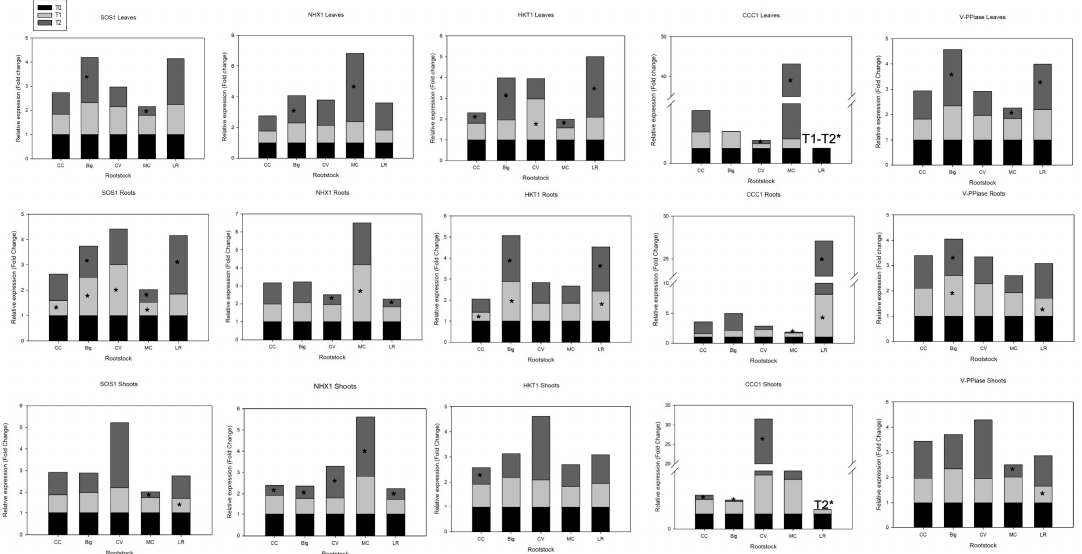
Figure 1. Expression profiles of SOS1, NHX1, HKT1, CCC1, and V-PPiase of ‘Hernandina’ clementine ( Citrus clementina hort. ex Tanaka) (willowleaf mandarin ( C. deliciosa ) × sweet orange ( C. sinensis (L.) Osbeck)) grafted on 5 citrus rootstocks in response to salt. Big: sour orange ( C. aurantium L.); CC: Carrizo citrange ( C. sinensis × Poncirus trifoliata (L.) Raf); CV: Volkamer lemon ( C. volkameriana V. Ten. & Pasq.); LR: Rangpur lime ( C. limonia Osbeck); and MC: Cleopatra mandarin ( Citrus reshni hort. ex Tanaka). For each combination (rootstock/‘Hernandina’), stacked panels showed gene expression in plant tissue (leaves, shoots, and roots) treated with NaCl (T1: 35 mM NaCl and T2: 70 mM NaCl) relative to untreated samples (T 0 = only nutrient solution without salt treatment). Relative gene expression was calculated using 2 − ∆∆ CT method (fold change). * Significant differences for p -values <